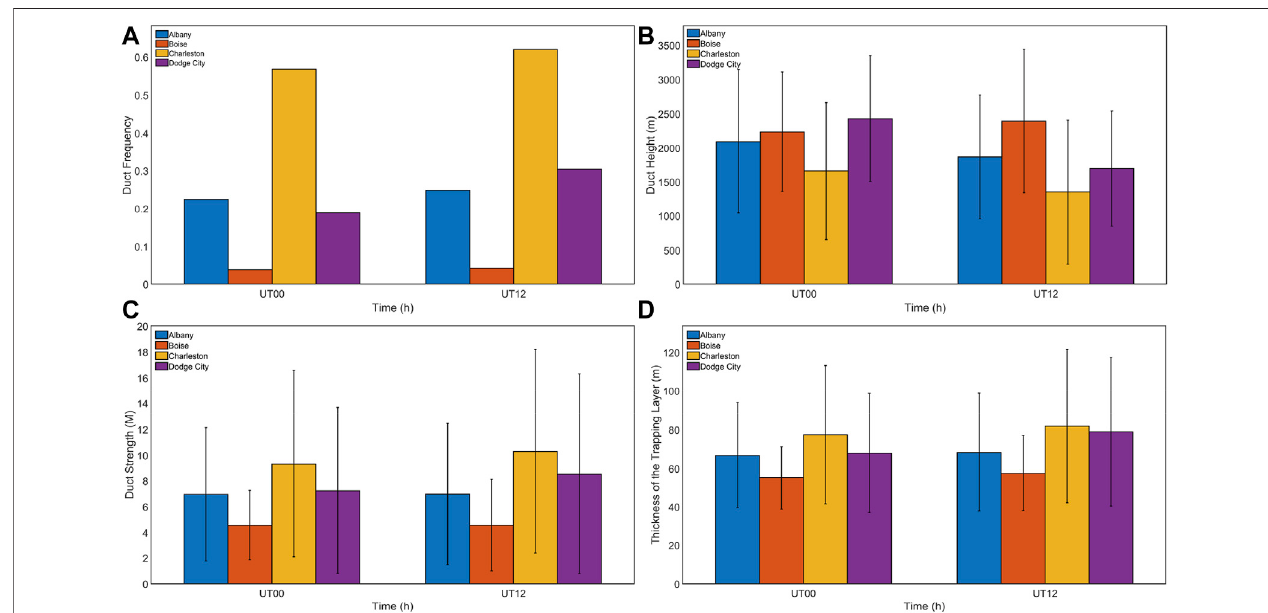
FIGURE12| Diurnalvariationoftheductfrequency,theductheight,theductstrength, andthethicknessofthetrappinglayeroverthefourstations (A – D) .The fi rst group of bars of each subgraph represents the parameters at UT00 and the second represents the parameters at UT12.